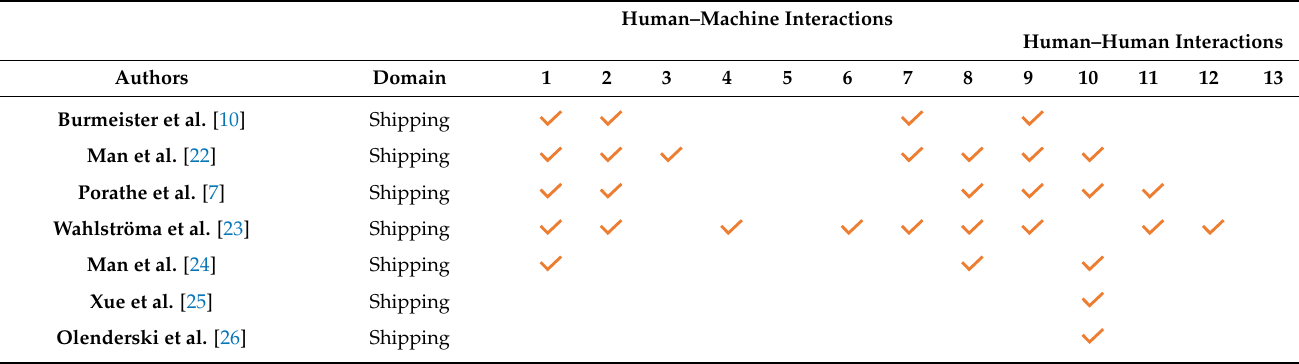
Table 2. Human factor issues in remote operations.